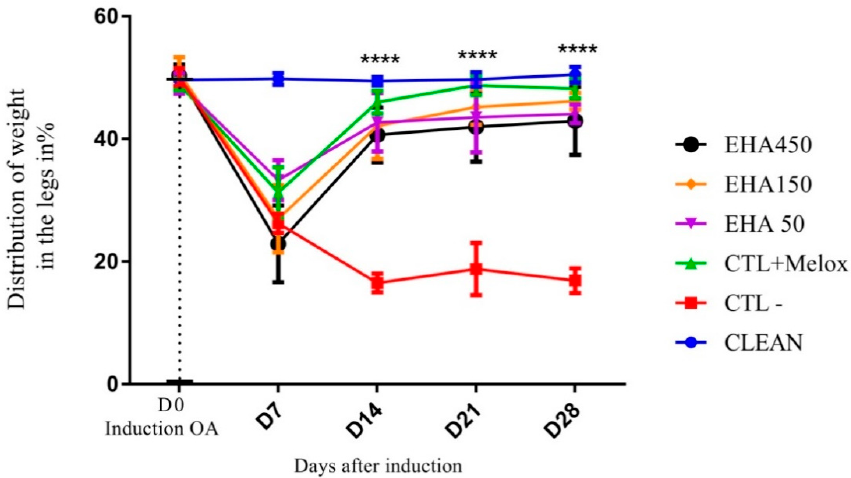
Figure 3. E ff ects of the extract A. chica on the degree of incapacitation of rats with induced osteoarthritis. The induction of osteoarthritis was done by the injection of MIA (2 mg) in the knee of Wistar rats. After 3